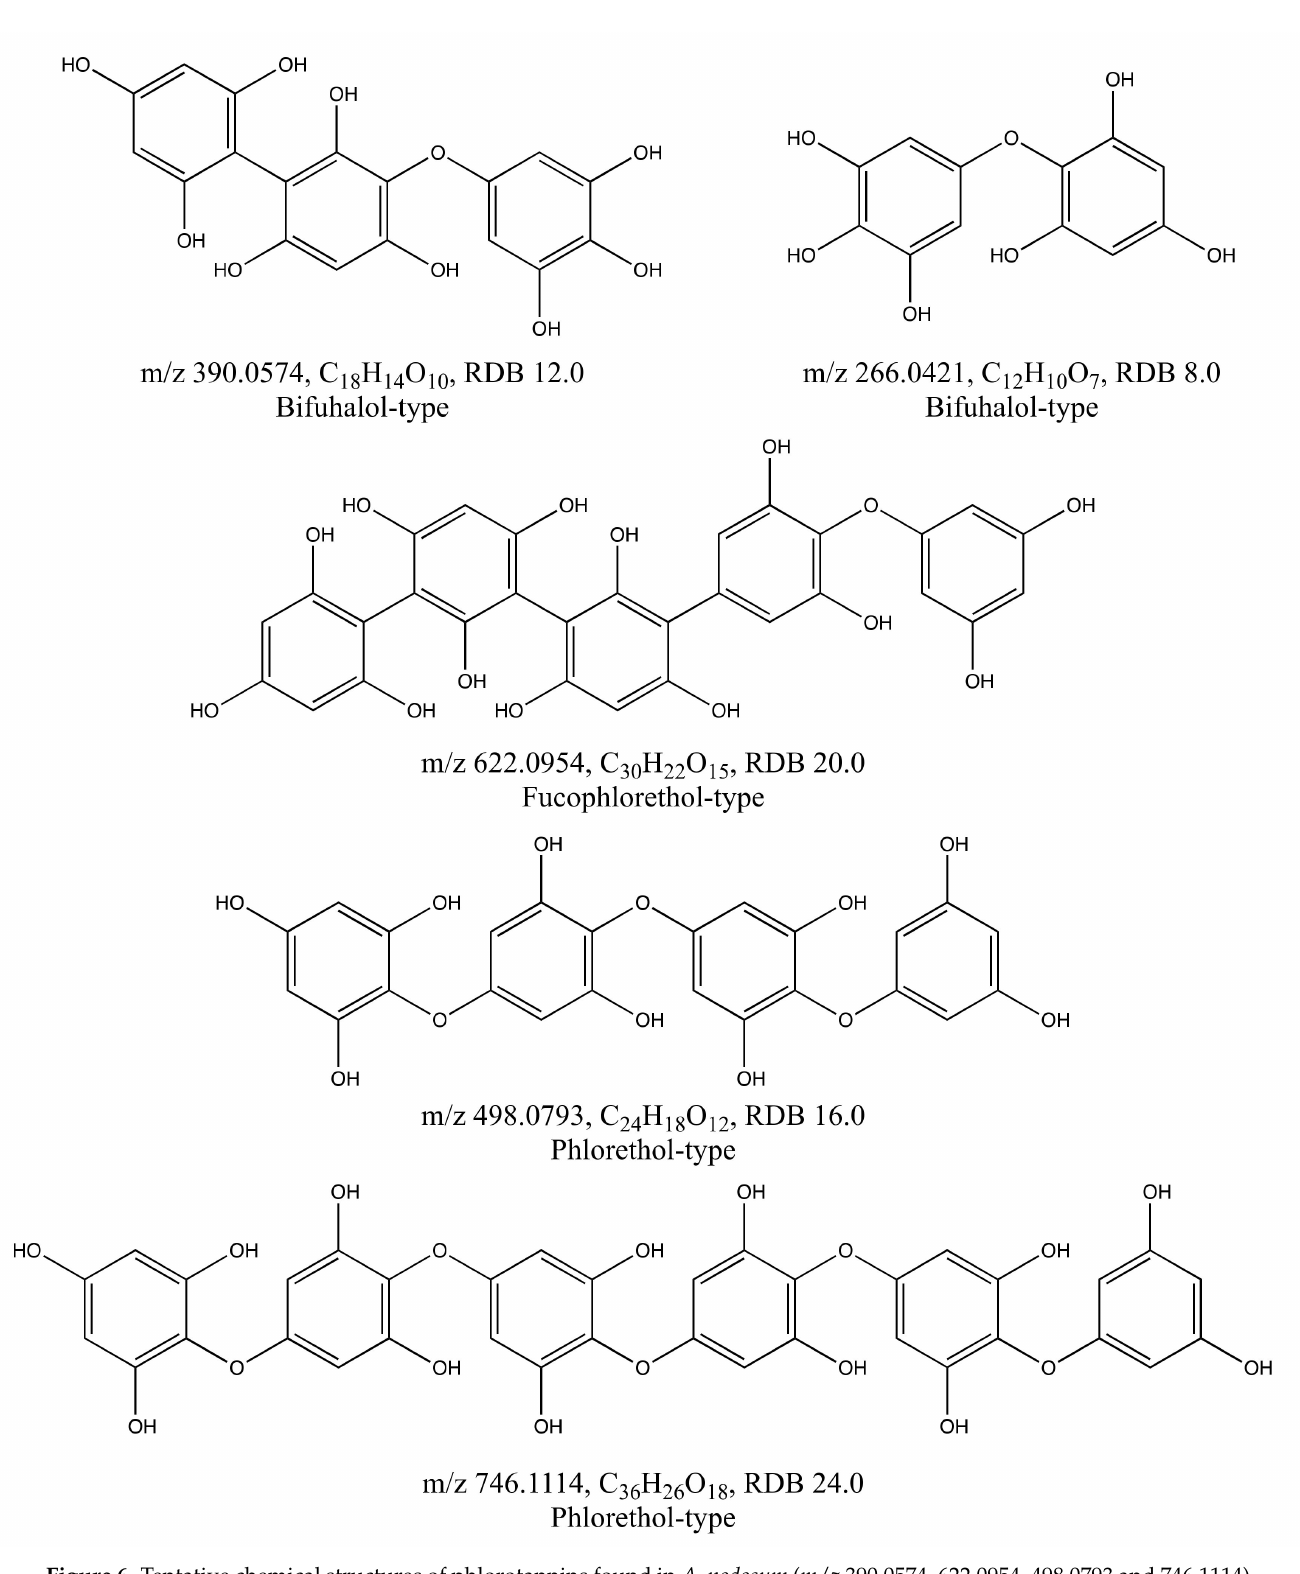
Figure 6. Tentative chemical structures of phlorotannins found in A. nodosum ( m / z 390.0574, 622.0954, 498.0793 and 746.1114) and S. latissima ( m / z 266.0421). RDB = ring double bond